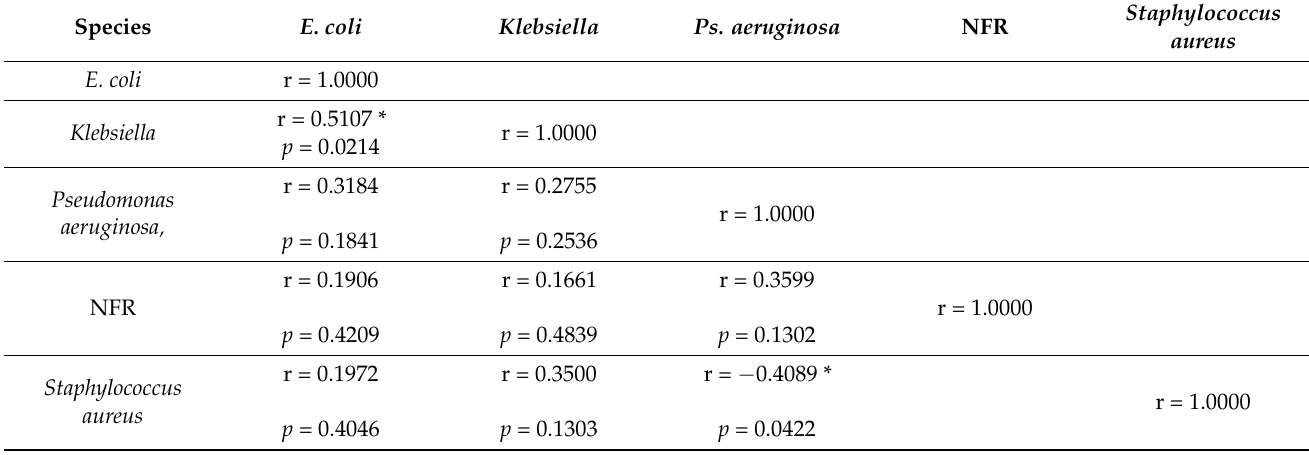
Table 3. Correlation between values of the monthly resistance index of E. coli, Klebsiella, Pseudomonas aeruginosa , non- fermenter Gram-negative rods (NFR) and Staphylococcus aureus .